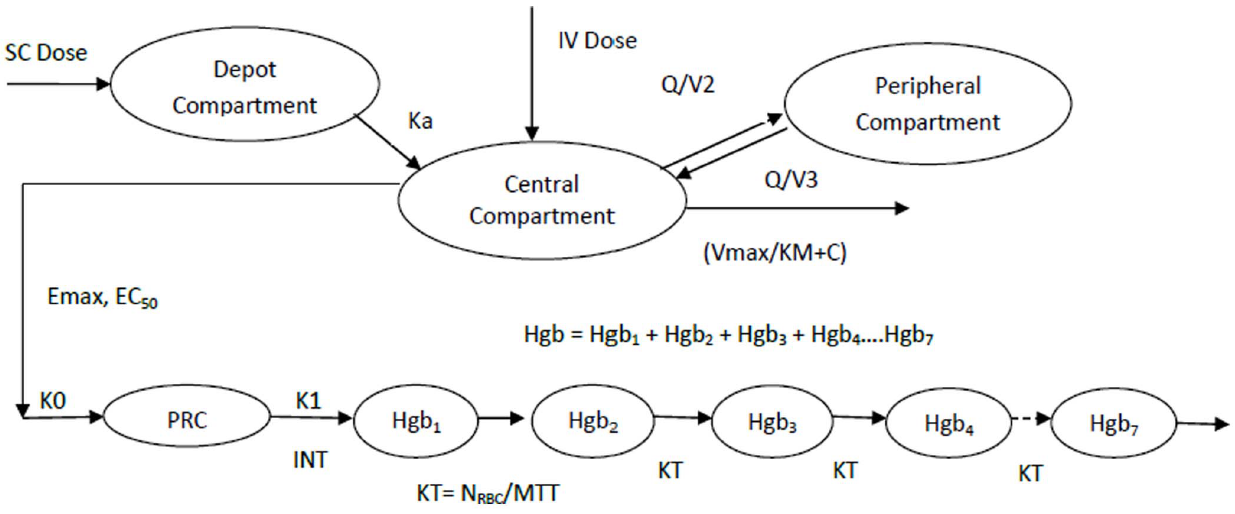
Figure 1. Schematic of two-compartment, precursor-dependent, lifespan indirect response population PK/PD model for peginesatide following subcutaneous or intravenous administration. Abbreviations: SC=subcutaneous; Ka=Absorption rate constant (1/hr); IV=intravenous; Q=Apparent distribution clearance from the central to the peripheral compartment (mL/kg/hr); V3= Peripheral volume of distribution; V2= Central volume of distribution; Vmax=Maximum rate of elimination (ng/mL/hr); KM=Concentration needed to reach 50% of Vmax (ng/mL); C=Peginesatide serum concentration (ng/mL); Hgb=Hemoglobin (g/dL); Hgb 1–7 = Transit Compartment; Emax=Maximum stimulatory effect of peginesatide on progenitor cell production; EC 50 = Peginesatide serum concentration necessary to stimulate progenitor cell production rate at half of the maximum response (ng/mL); K0= Endogenous production rate constant of progenitor cells; PRC=Precursor cell compartment; K1= First-order transition rate constant from precursor cell to red blood cell; KT=First-order rate constant between the aging compartments; N RBC / MTT=Life span of red blood cells.